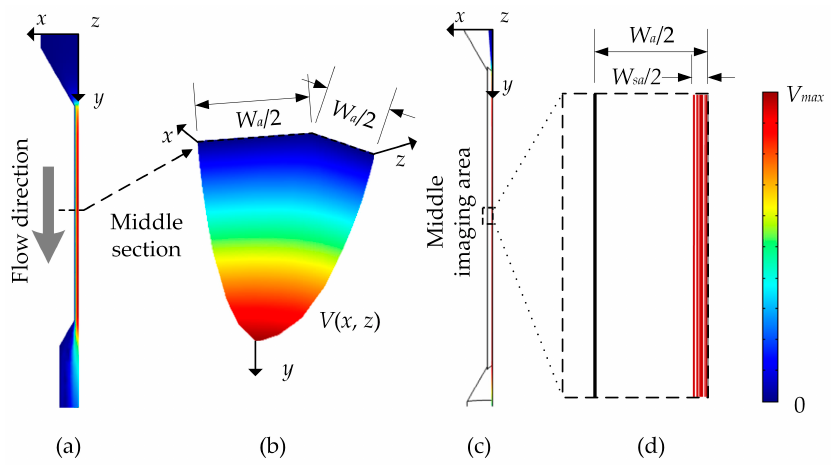
Figure 3. Flow velocity profile at ( a ) vertical cross section and ( b ) horizontal cross section of the micro-channel. Sample particle velocity profile at ( c ) side view and ( d ) the middle imaging area of the micro-channel.